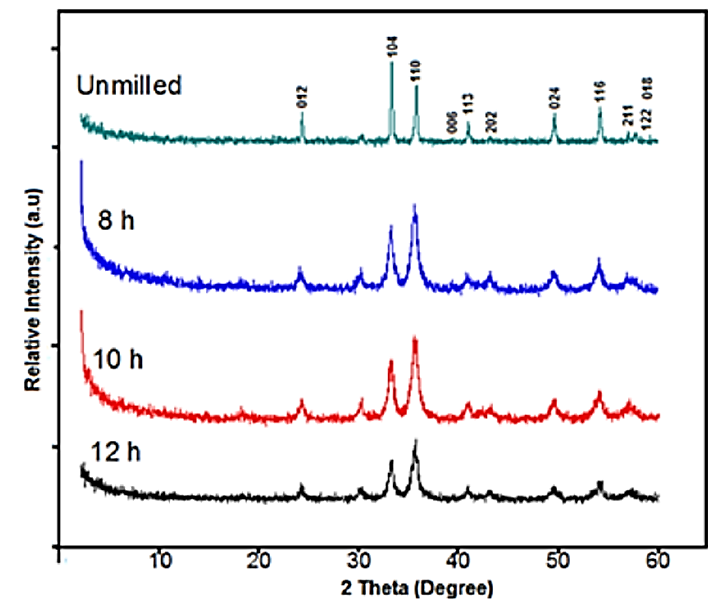
Figure 4. XRD di ff ractograms of the recycled α -Fe 2 O 3 Figure 4. XRD diffractograms of the recycled α -Fe 2 O 3 particles.